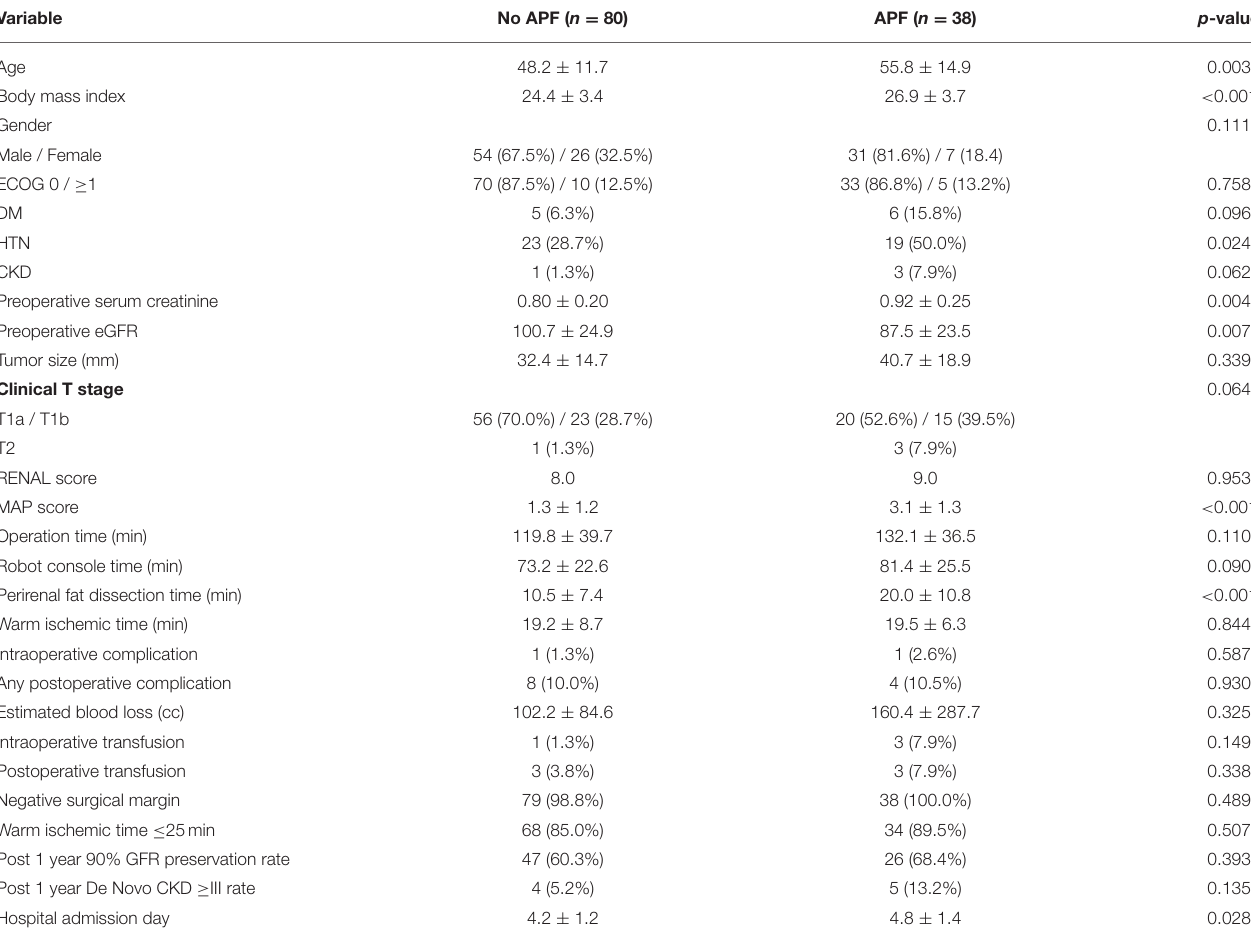
TABLE 1 | Perioperative outcomes between no adherent perinephric fat (APF) and APF groups.